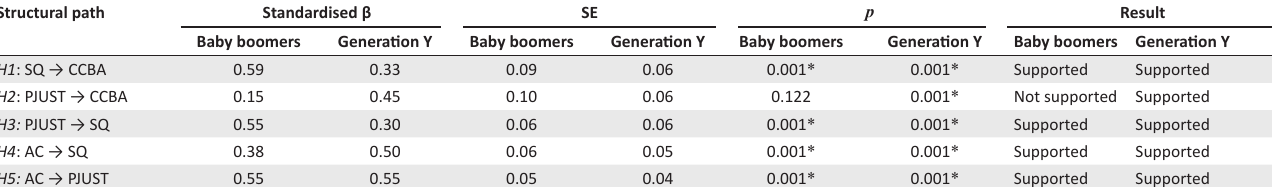
TABLE 5: Multi-group structural equation modelling results. Structural path